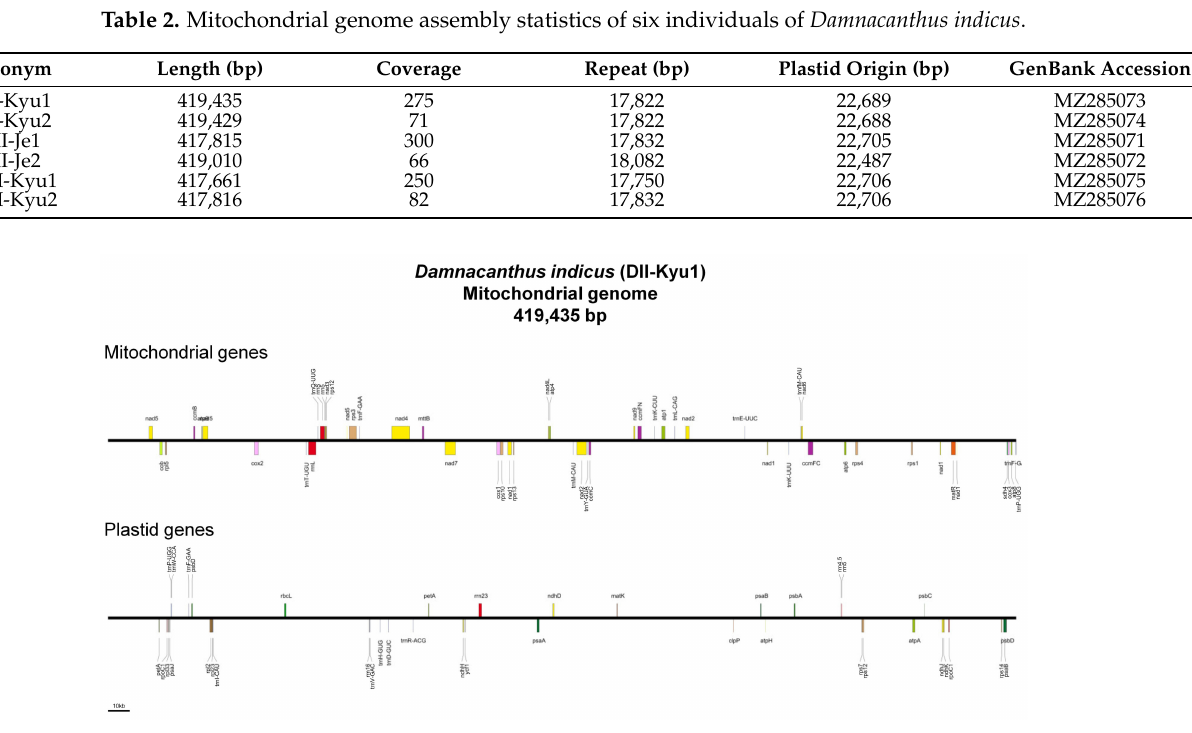
Figure 2. Maps of a representative mitochondrial genome (DII-Kyu1) of Damnacanthus indicus . Two maps showing genes of mitochondrial and plastid origins are presented, respectively. Annotations include only intact mitochondrial genes, while for plastid genes, those also include fragmented copies.